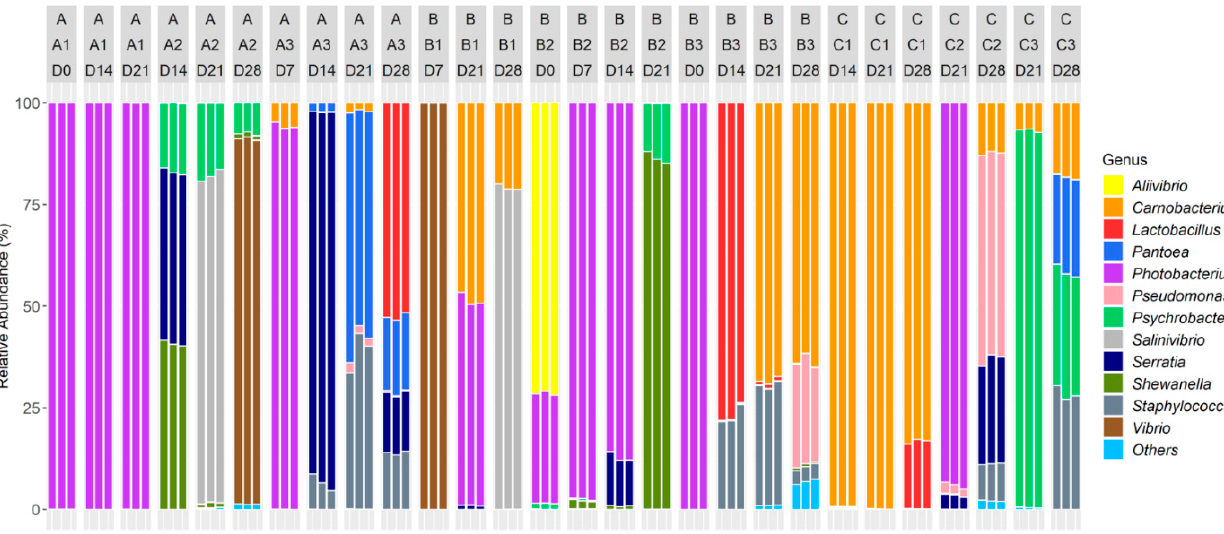
Figure 4. Relative abundance of bacterial genera of vacuum-packed cold-smoked salmon products stored during 28 days (D0, D7, D14, D21, D28). Three different production batches (e.g., A1, A2, A3) were processed in three different processing factories (A, B, C). Only 84 samples are represented: 6 DNA could not be amplified and 45 outliers were removed due to a low number of reads (<10,000). The removed samples were identified in some D0, D7, D14 and D28 samples. Taxa present on average in all samples at a threshold ≥ 0.5% or having a 90th percentile ≥ 0.5% are individually represented. In other cases, taxa are grouped and labeled “Others”.